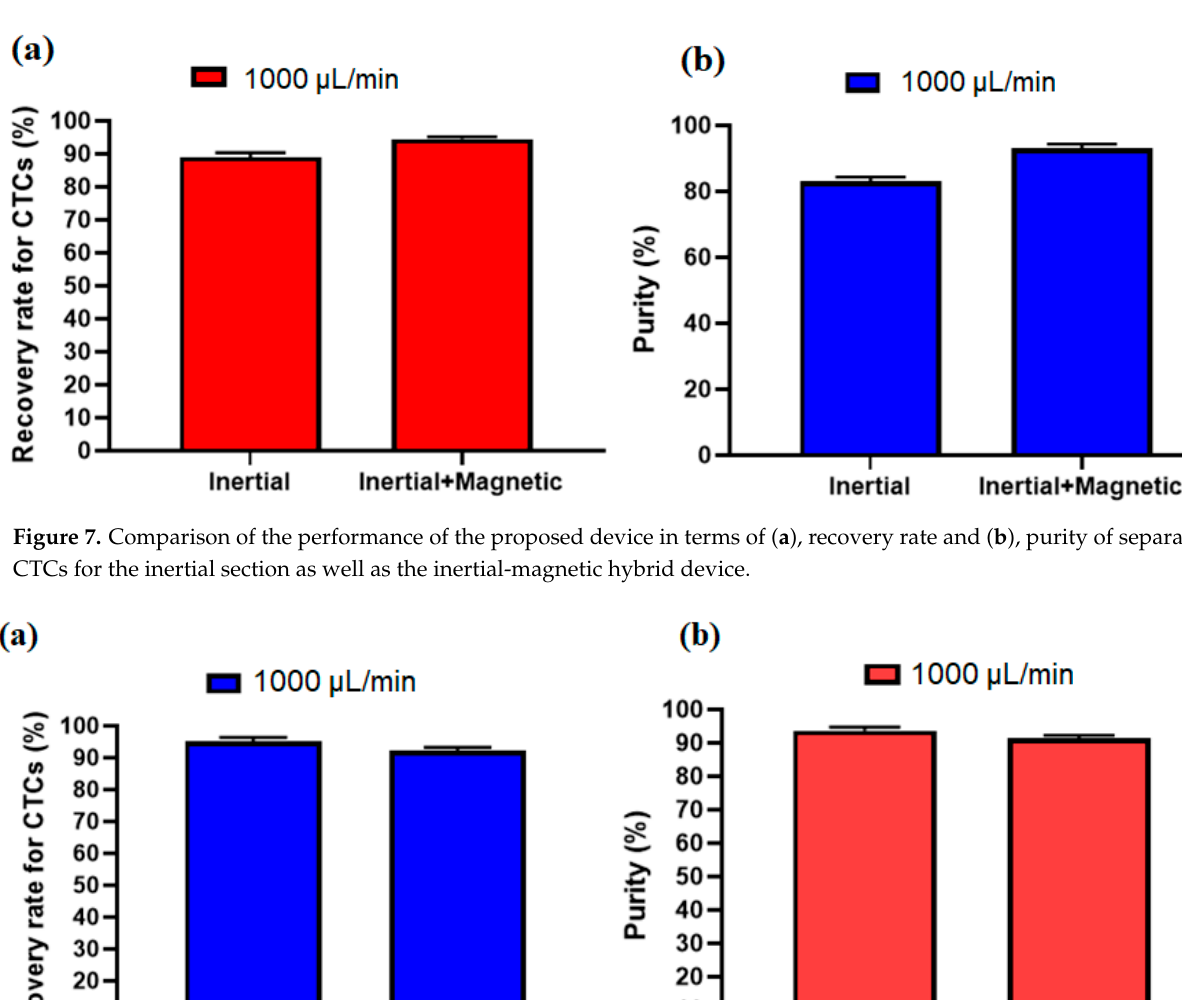
Figure 7. Comparison of the performance of the proposed device in terms of ( a ), recovery rate and ( b ), purity of separated CTCs for the inertial section as well as the inertial-magnetic hybrid device.